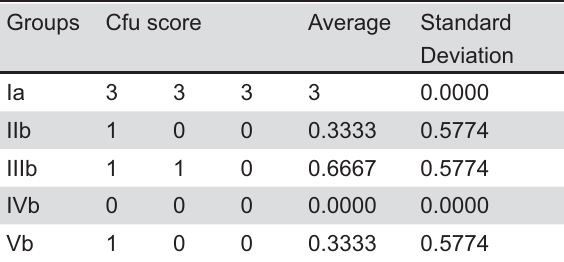
Figure 1- Bovine premolar tooth, and enamel surface